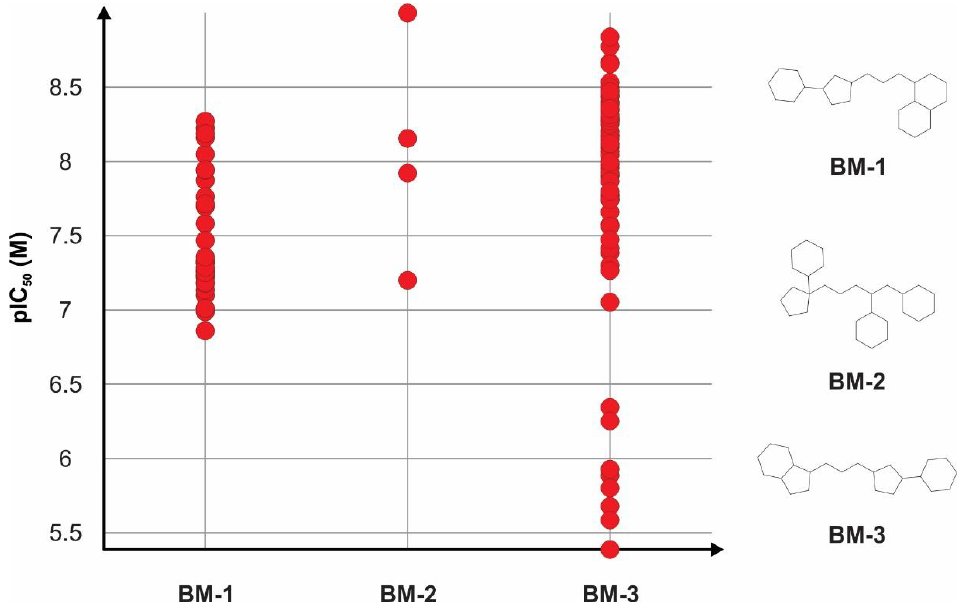
Figure 2. Bemis-Murcko skeletons identified with significant differences in TRPA1 inhibitory activity using statistical comparison of mean pIC 50 values.